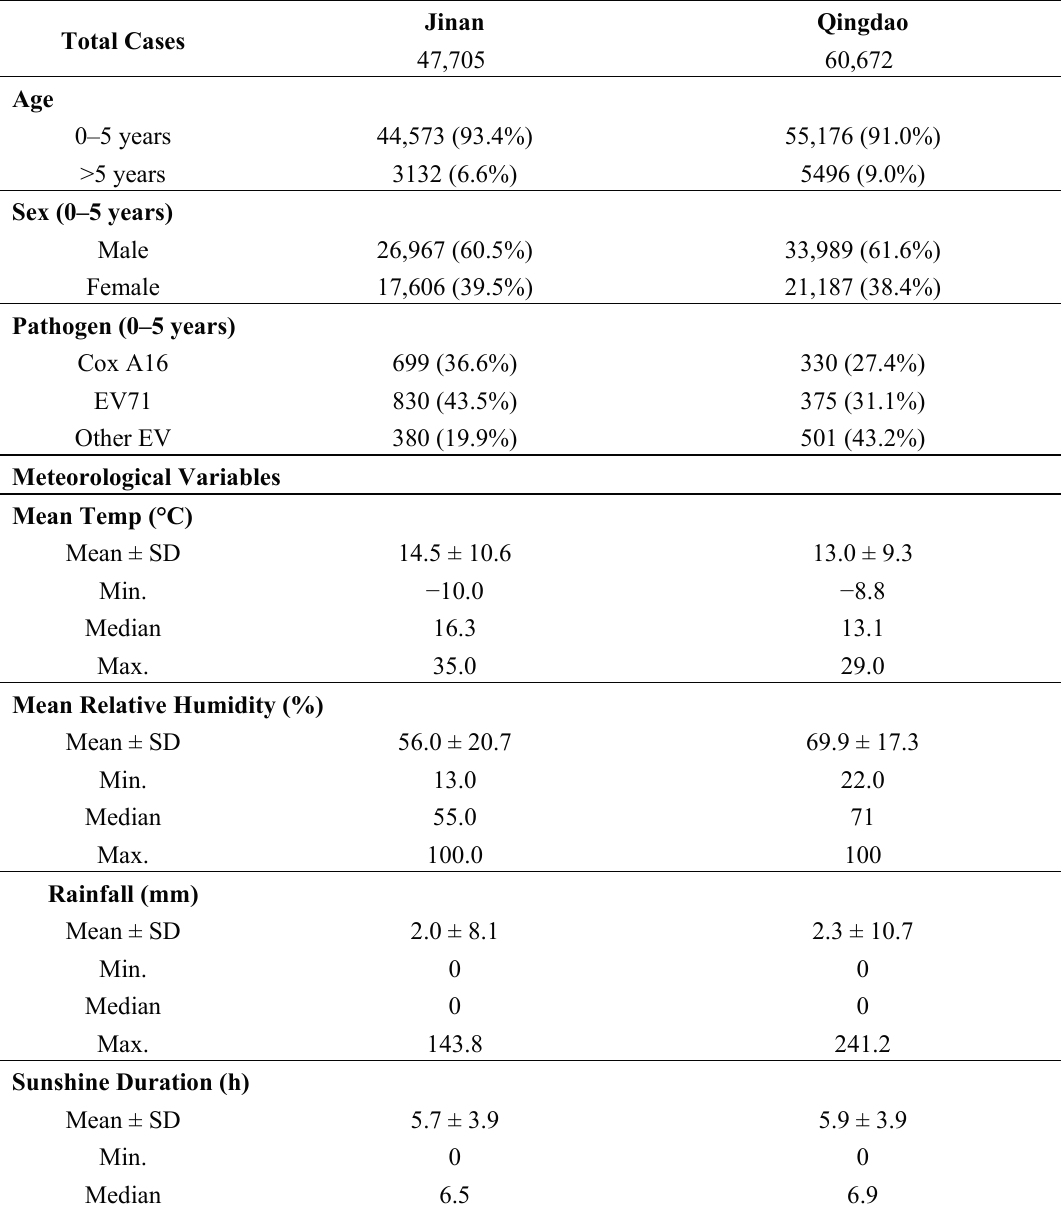
Table 1. Basic demographic characteristics of HFMD cases and meteorological data in Jinan and Qingdao,